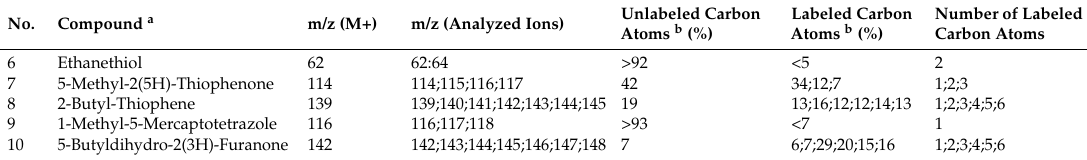
Table 5. Proportion of isotopomers formed from [ 13 C 6 ]glucose and